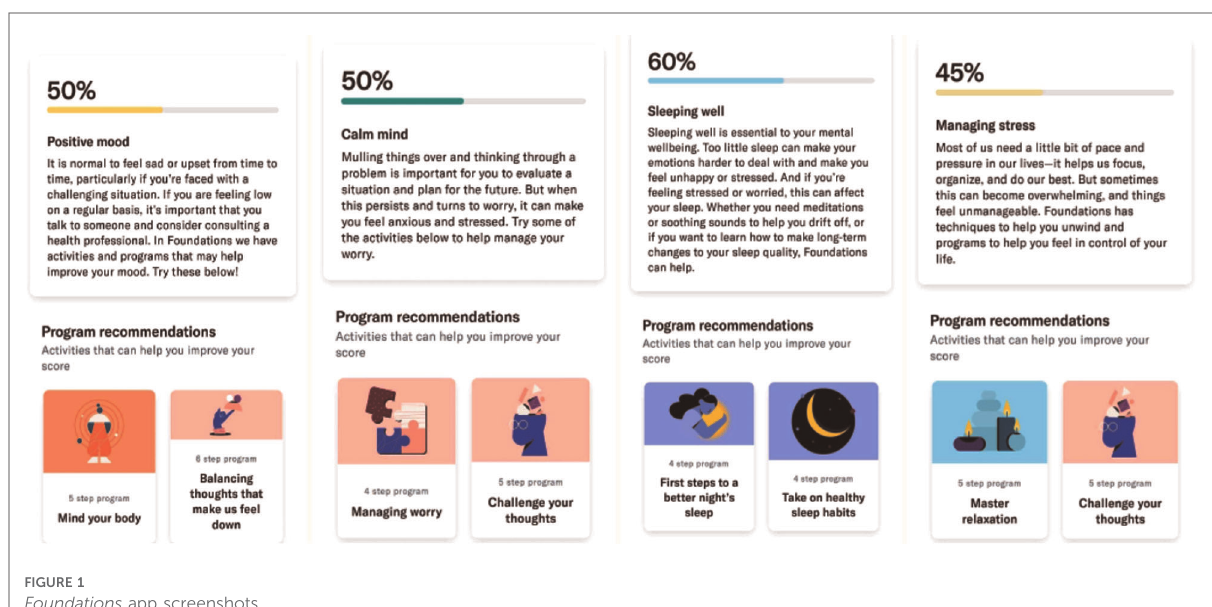
FIGURE 1 Foundations app